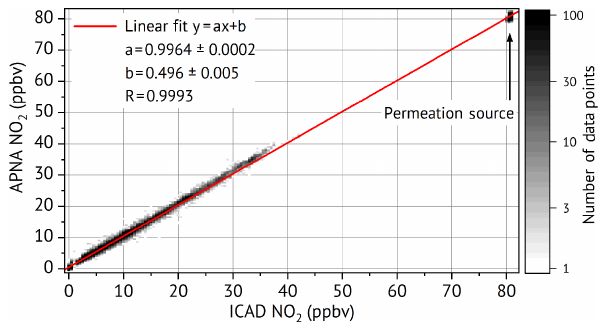
Figure 13. Correlation plot between ICAD NO 2 A and APNA-370 CLD